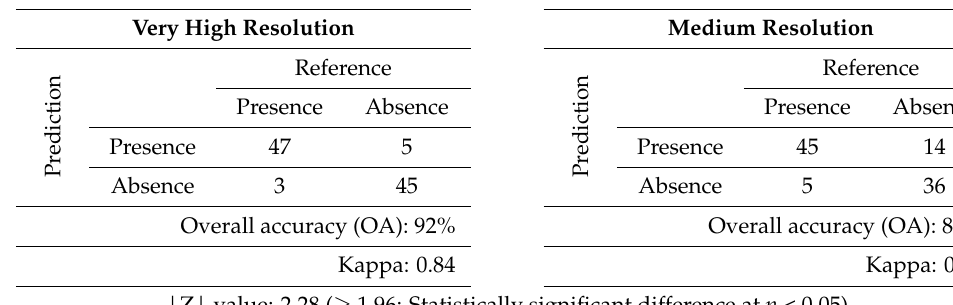
Figure 3. Comparison of the overall area mapped with different size polygons, using satellite imagery of very high resolution (VHR, red) and medium resolution (MR, blue) for ( a ) the tall tree growth form (Cuban cedar), ( b ) the medium tree growth form (guava), and ( c ) the shrub growth form (blackberry). Table 3. Very-high-resolution (VHR) and medium-resolution (MR) confusion matrix obtained for the tall tree growth form (Cuban